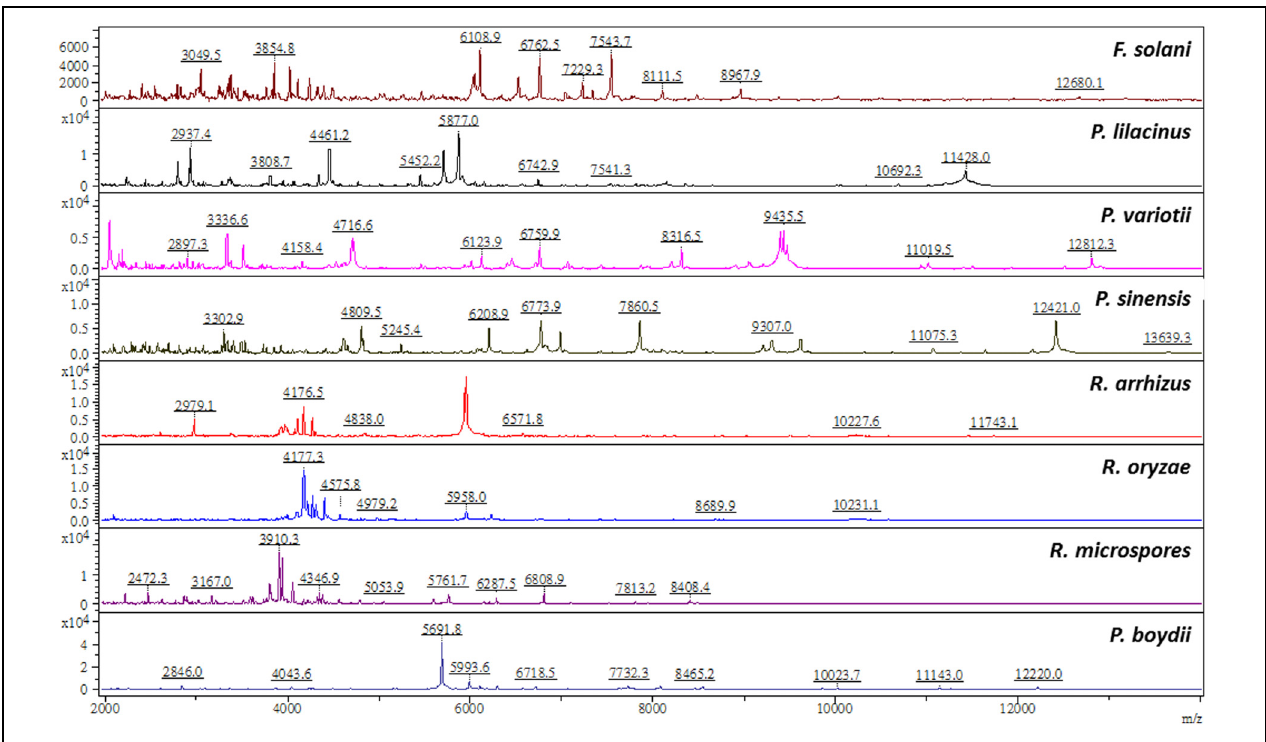
FIGURE 3 | Spectra of Paecilomyces variotii , Fusarium solani , Paecilomyces lilacinus, Paecilomyces sinensis , Rhizopus arrhizus, Rhizopus oryzae, Rhizopus microspores, and Pseudallescheria boydii